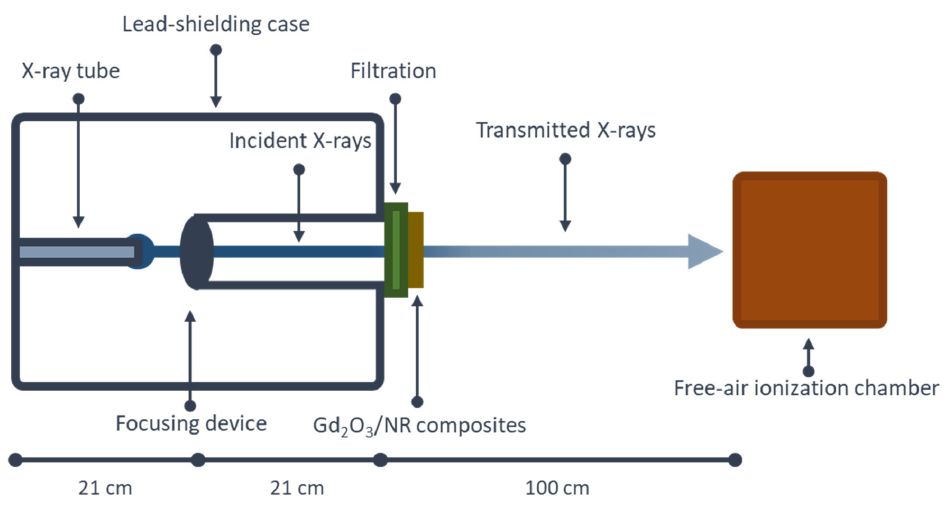
Figure 3. Schematic setup for X-ray-shielding